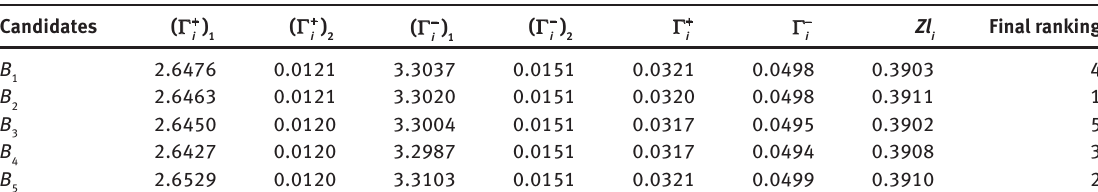
Table 18: Proposed CF-MAGDM Model Multi-Attribute Group Decision-Making Model. Candidates